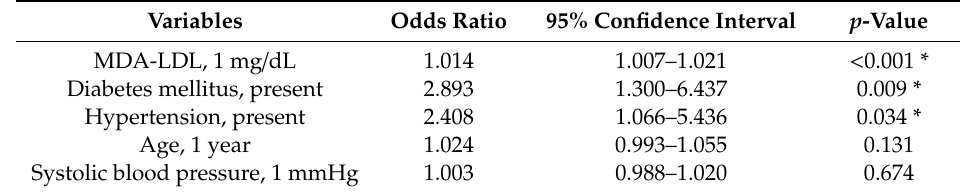
Table 2. Multivariate logistic regression analysis of the factors correlated to AS among 155 HD